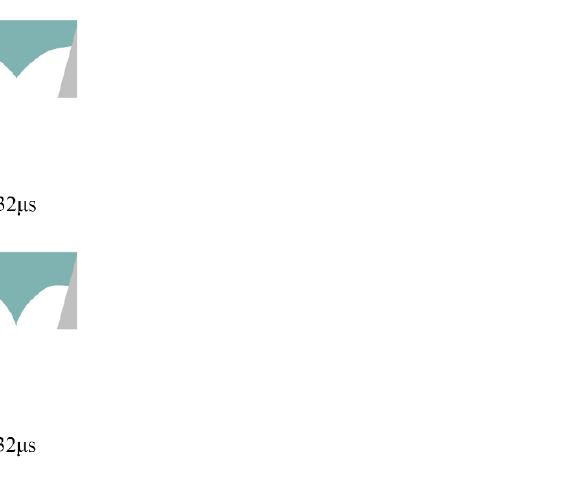
Figure 6. Simulation results of meniscus motion at the nozzle when the t r is 4 µs and 5 µs.